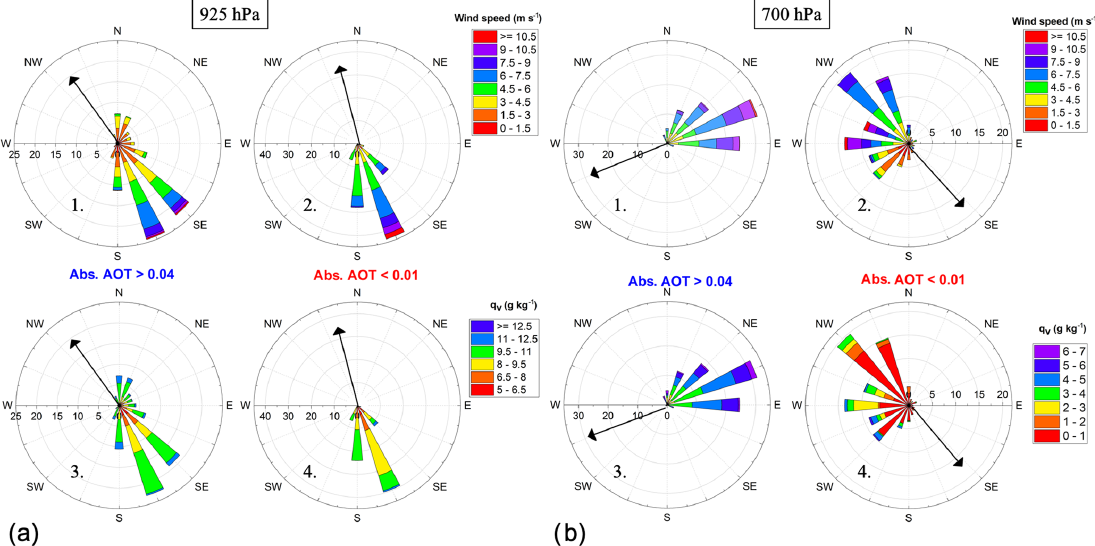
Figure 9. Wind speed rose (1–2) and specific humidity rose (3–4) at 925hPa (a) and 700hPa (b) for situations with absorption AOT larger than 0.04 (1–3) and with absorption AOT smaller than 0.01 (2–4). The radius shows the frequency of wind direction. The arrow represents the main wind